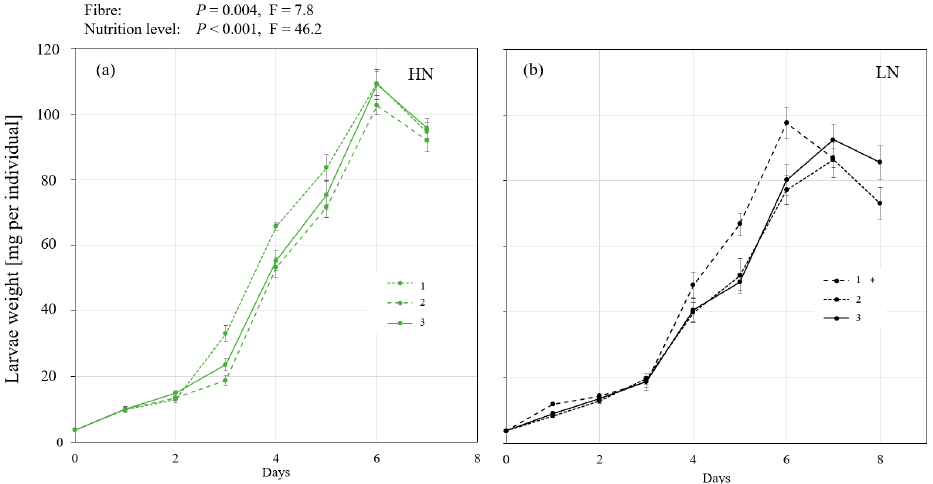
Figure 1. The growth of black soldier fly larvae (BSFL) on different fibre components and two nutrient levels (experiment 1). BSFL were grown in high-nutrient (HN, ( a )) or low-nutrient (LN, ( b )) substrates and with 3 fibre components (1: powder cellulose, 2: lignocellulose, or 3: ground straw). The single-larva fresh weight was measured over time, and the daily means and standard errors are shown in the graph. Linear mixed-effect model analysis followed by a Bonferroni post hoc test revealed a significant impact of both factors (nutrient level and fibre) on growth over time. The significant difference between fibre treatments in a nutrient level is indicated by an asterisk.